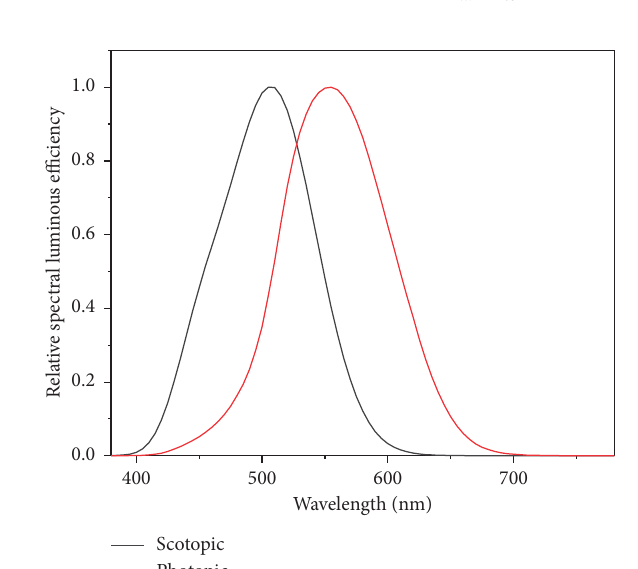
Figure 4: The calculation process of k